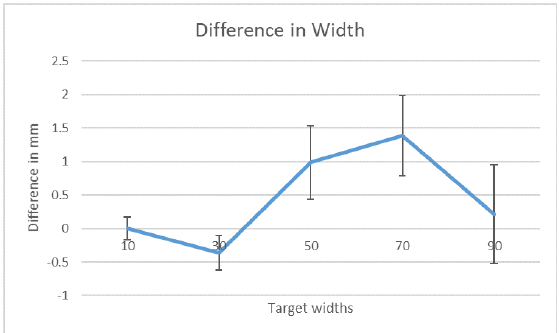
Figure 10. Difference from the final mean and target in mm for width adjustments (error bars depict standard error of the overall mean